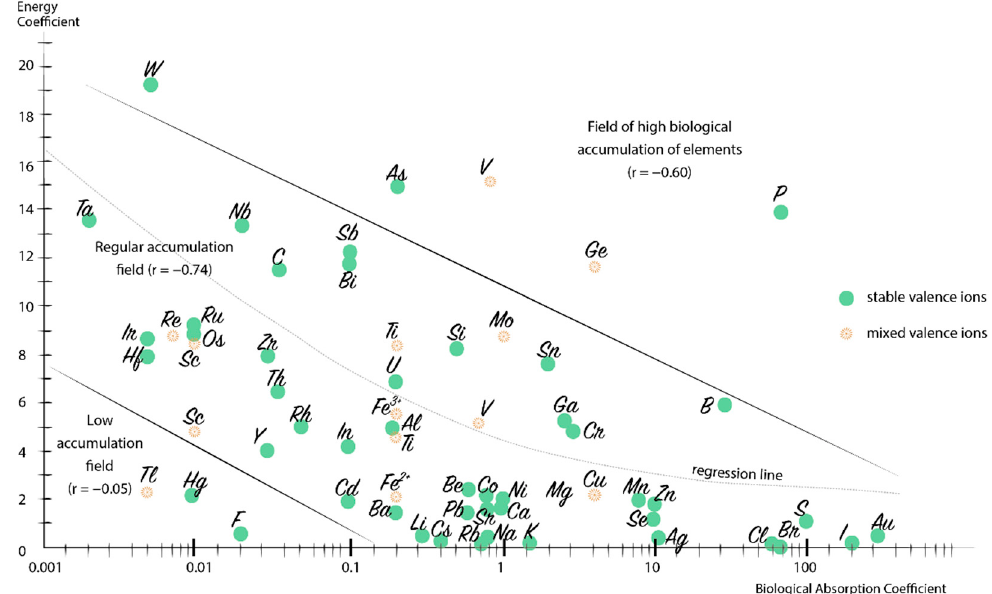
Figure 9. Accumulation of the chemical elements by plants as a function of the energy coefficient and the common logarithm of the biological absorption coefficient value.